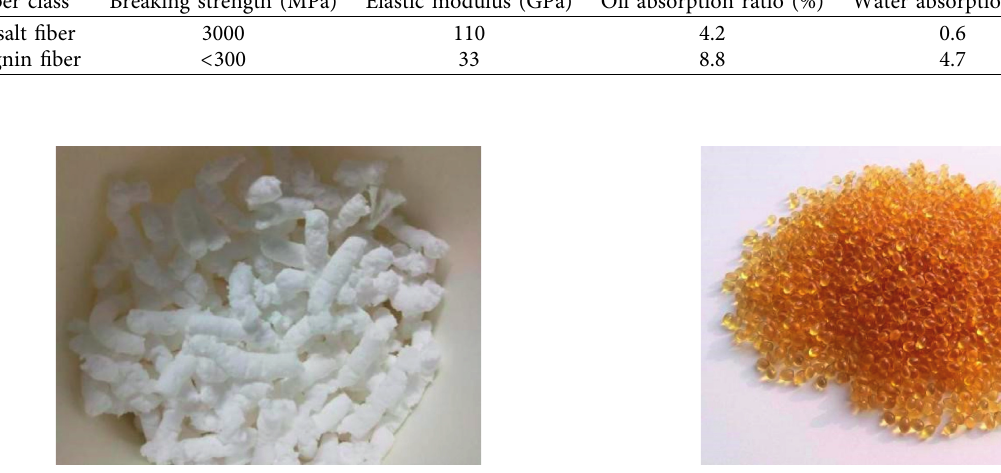
Figure 1: The SBS modifier. Figure 2: The TPS